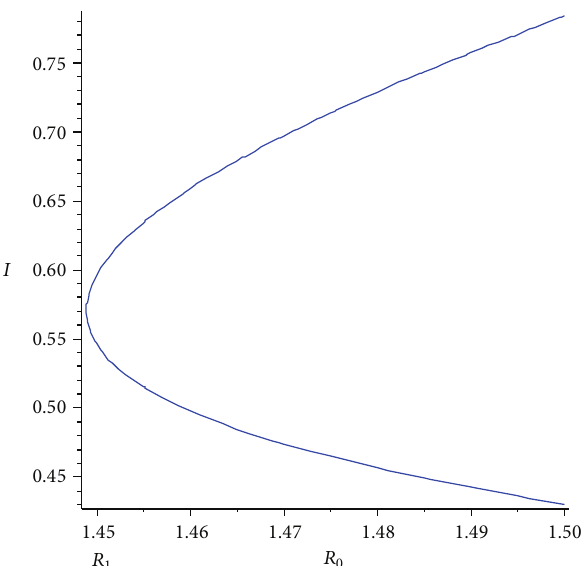
Figure 2: The bifurcation curves the palne of (𝐼, 𝑅 0 )